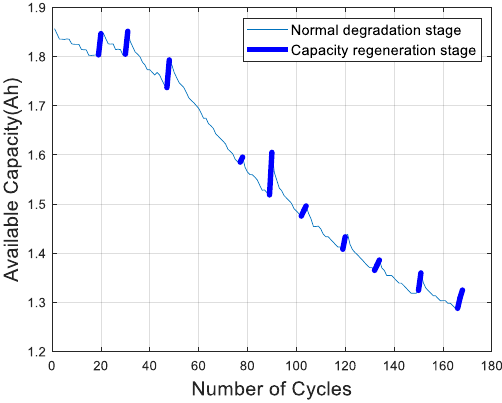
Figure 2. Degradation process curve of No. 5 battery.